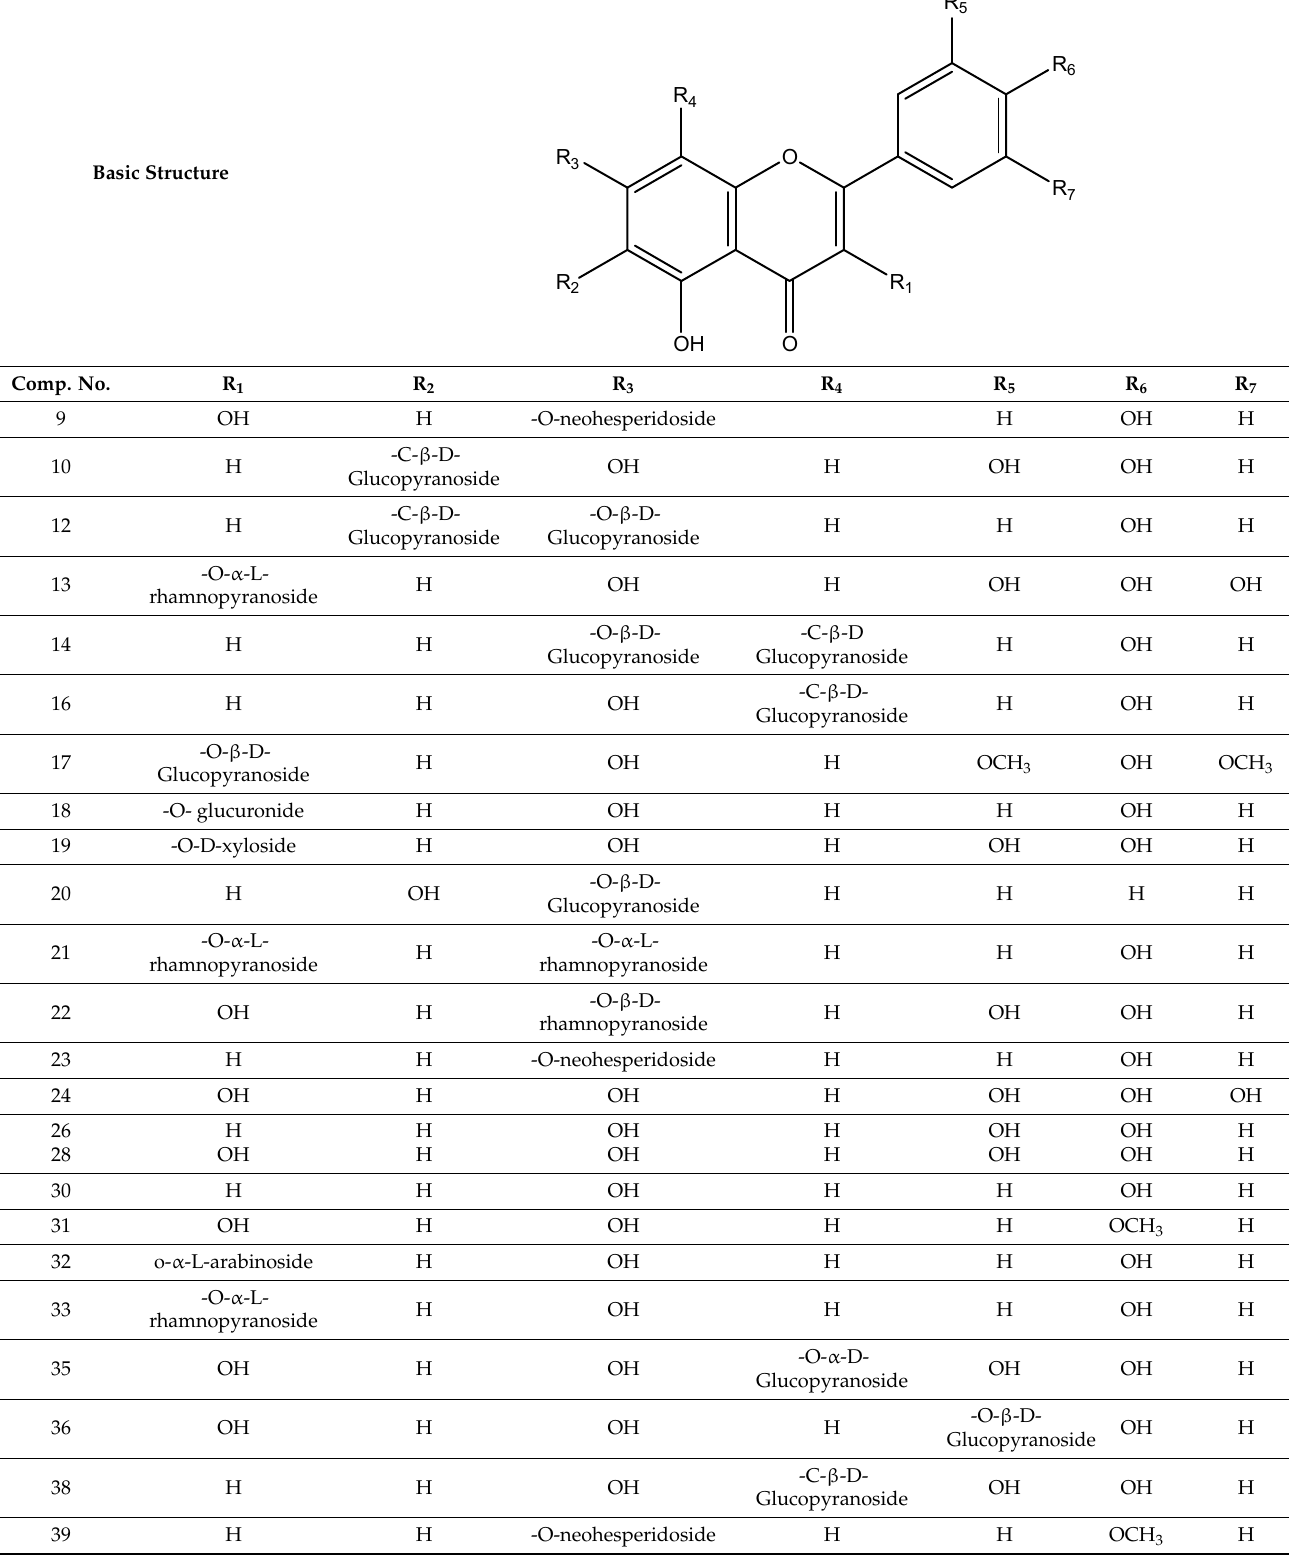
Table 3. Compounds tentatively identified by UHPLC/QTOF–MS of S. sieboldii extract.